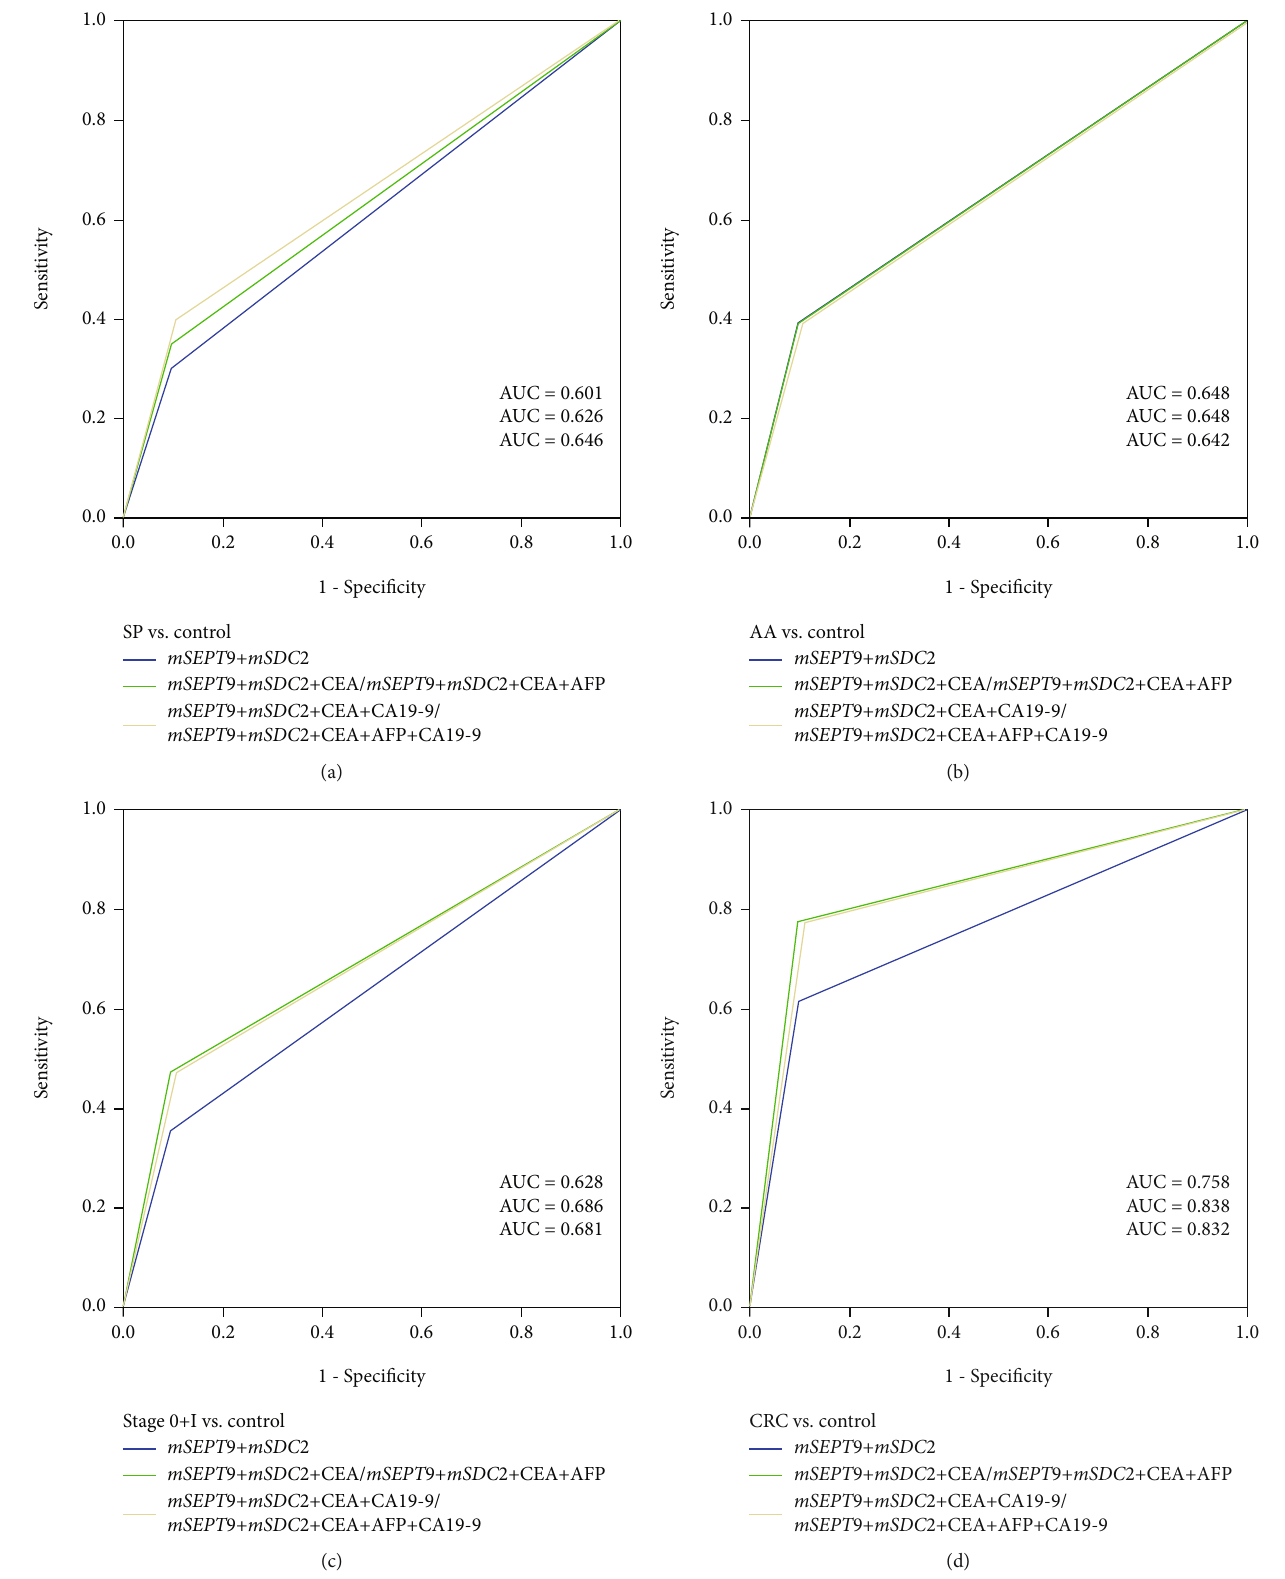
Figure 4: ROC curves for combined ColoDefense and tumor marker tests in detecting (a) SP, (b) AA, (c) stage 0 and I CRC, and (d) all